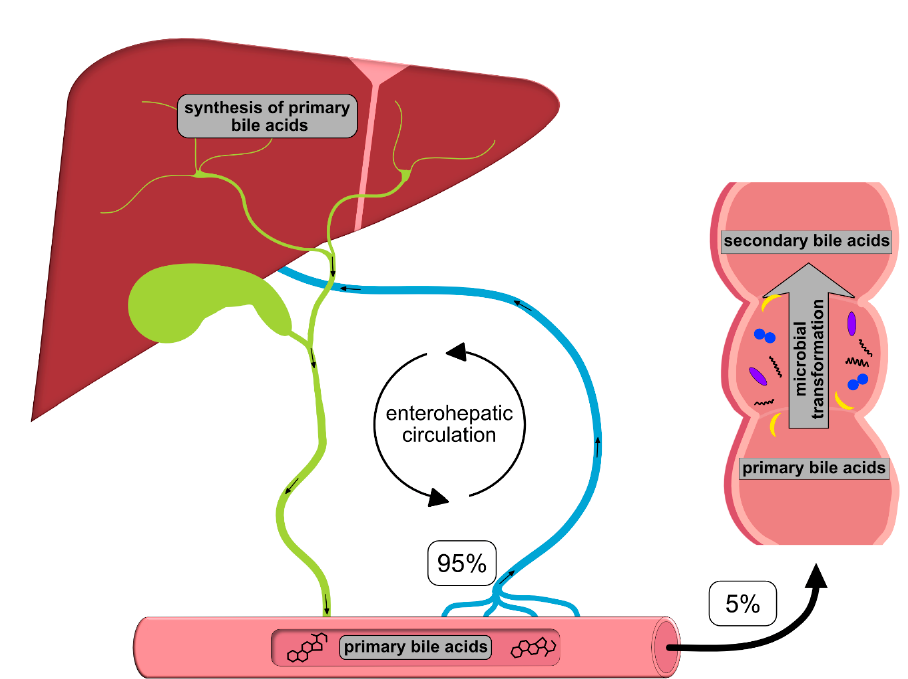
Figure 1. Schematic overview of the enterohepatic circulation (EHC). Primary bile acids (BAs) are synthesized in the liver and secreted into the duodenum with the bile; 95% of the BAs are re-absorbed in the terminal ileum and transported back to the liver for recycling. The remaining 5% enter the colon, where they are transformed into secondary BAs by colonic microbiota.